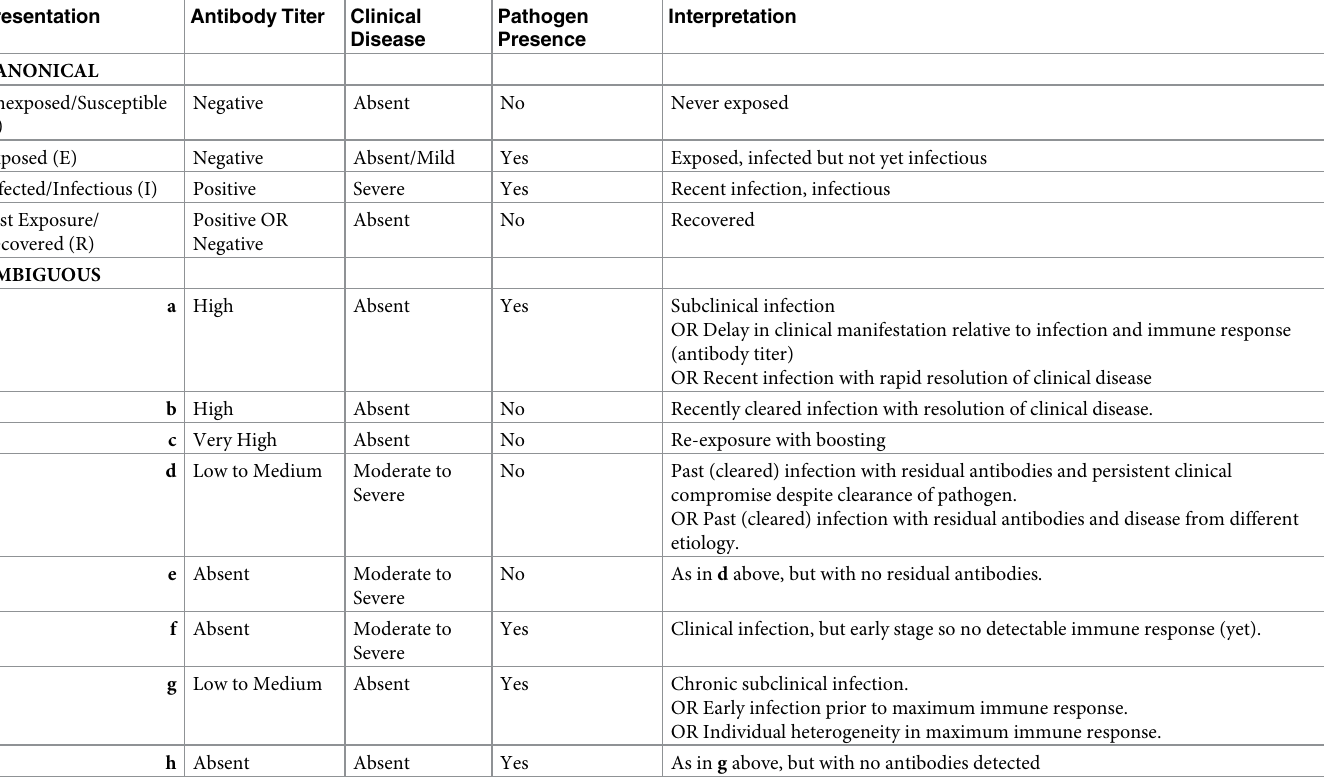
Table 1. Description of expected biomarker levels found in individuals using an understanding of disease dynamics in a system based on the more traditional (CANONICAL) framework and expanding that framework to include greater complexities and more ambiguous presentations